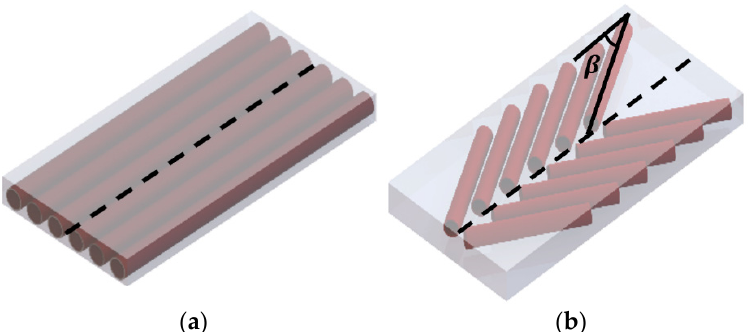
Figure 1. ( a ) Parallel topology; ( b ) Bipennate topology. Three-dimensional visual representation of muscle topologies considered. The shaded region indicates the bounding envelope. The black dashed centerline is the muscle axis of motion. The β shown in ( b ) indicates the pennation angle or angle at which the fiber is oriented with respect to the muscle line of motion.